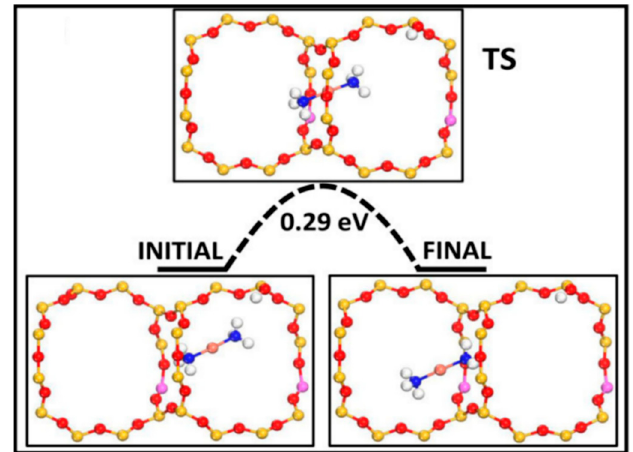
Figure 2. Diffusion barrier across an eight-membered ring in SSZ-13 for [Cu + (NH 3 ) 2 ]: the bottom left and right structures show the initial and final configurations, respectively. TS: transition-state structure. Reproduced with permission from [81], copyright American Chemical Society, 2016.